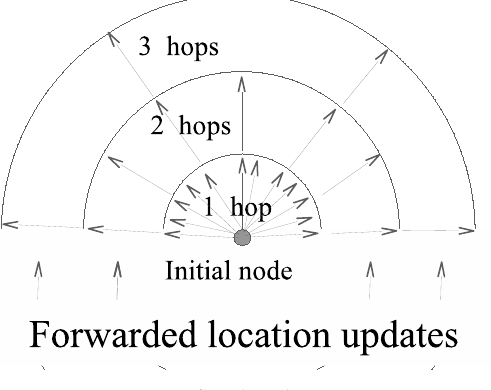
Figure 2. Semiflooding location